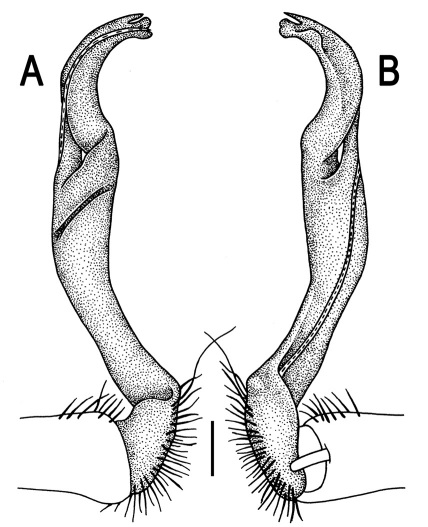
Orthomorpha holorogiformis Golovatch, 1998, ♂ from Khao Chao Priest Residence. A, B right gonopod, lateral and mesal views, respectively. Scale bar: 0.2 mm.